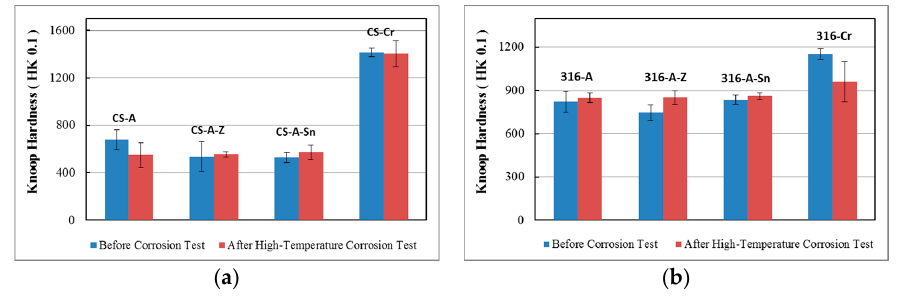
Figure 16. Comparison of Knoop hardness of the case depth before and after the high-temperature corrosive attack for ( a ) coated low carbon steel, and ( b ) coated 316 stainless steel substrates.